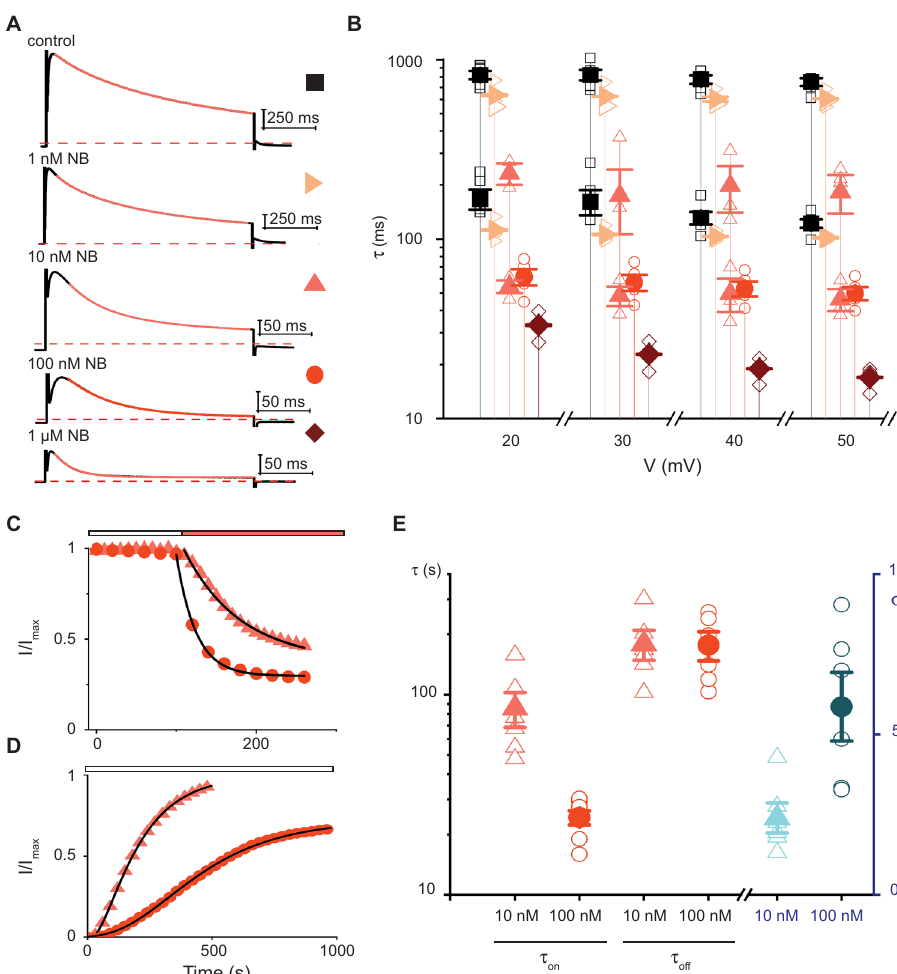
Fig. 4 Concentration-dependence for acceleration of inactivation by the nanobody. A Kv1.3 current traces elicited by depolarization to + 50 mV in 2 mM K + in the absence or presence of the NB. Holding voltage was − 80 mV, tail voltage was − 50 mV, current scale bars are 1 μ A and red dotted line is zero current. Control trace and 100 nM NB are from one cell, and traces for other NB concentrations are from three different cells. Orange lines are fi ts of mono- (100 nM and 1 µ M) or double exponential (control, 1 nM and 10 nM) functions (see Methods). B In fl uence of the NB on inactivation. Mean values for τ slow and τ fast are shown for control ( fi lled black squares; n = 5;), 1 nM NB (right facing light orange triangles; n = 3) or 10 nM NB ( fi lled upright pink triangles; n = 3). Mean values of τ are shown for 100 nM NB ( fi lled orange circles; n = 5) and for 1 µ M NB ( fi lled dark red diamonds; n = 3). Open symbols denote individual experiments. Error bars are S.E.M. C Onset of inhibition by NB in 2 mM K + solutions. Peak currents elicited by 500 ms steps from − 80 to + 40 mV were normalized to the maximum value in control. Addition of NB (orange bar) at 10 nM (triangles) or 100 nM (circles). Black lines are fi ts of a single exponential function to the data (see Methods). D Recovery from inhibition by the NB in 2 mM K + solutions. Same voltage protocol as C with removal of the NB indicated by white bar (10 nM NB triangles and 100 nM circles). Currents were scaled by setting the initial values in NB to zero and normalizing to the maximum before the addition of the NB. Pulses delivered every 10 s but shown every 30 s for clarity. Black lines are fi ts of a sigmoidal function to the data (see Methods). E Concentration dependence for onset ( τ on ) and recovery ( τ off ) for NB. Mean values ( fi lled symbols) for τ on ( n = 6 for 10 nM and 7 for 100 nM), τ off and σ ( n = 6), individual values (open symbols) from experiments like those in C , D . Error bars are S.E.M. Source data are provided as a Source Data fi (Fig. 5D, Supplementary Fig. 5) but the Fab region was modeled using a more conservative approach by generating a Fab homology model (PDB 6OO0 (bovine Fab NC-Cow1 structure)) and rigid body fi tting the homology model into the density map (Fig. 5D, Supplementary Fig. 5).